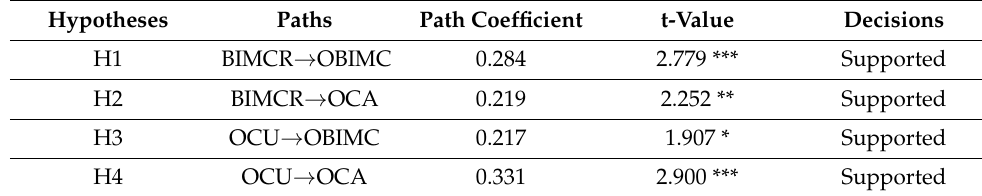
Table 8. Structural model